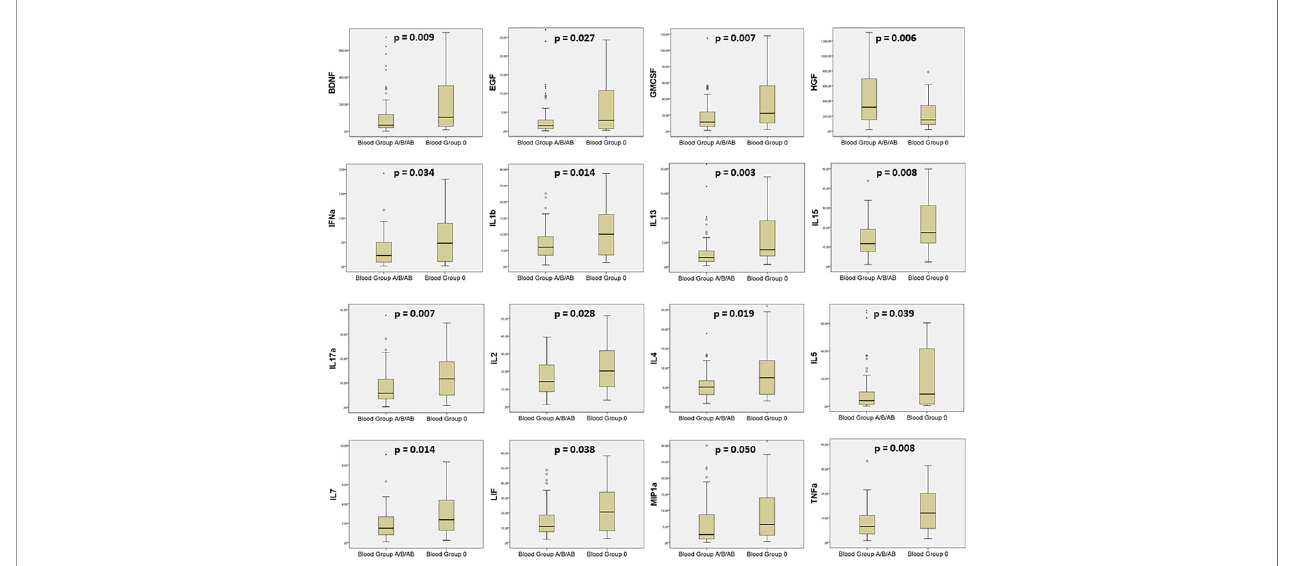
FIGURE 2 | Boxplots showing the statistically signi fi cant cytokines comparing blood group A/B/AB and blood group O